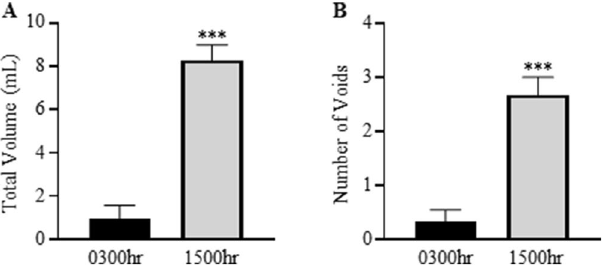
Figure 1. Guinea pigs voided more during the day. ( A ) The total volume voided during 3 h in the metabolic cages at 0300 h and 1500 h. ( B ) Number of voids during 3 h in the metabolic cages at 0300 h and 1500 h. N = 6 guinea pigs for both time points. ***P < 0.001 vs 0300